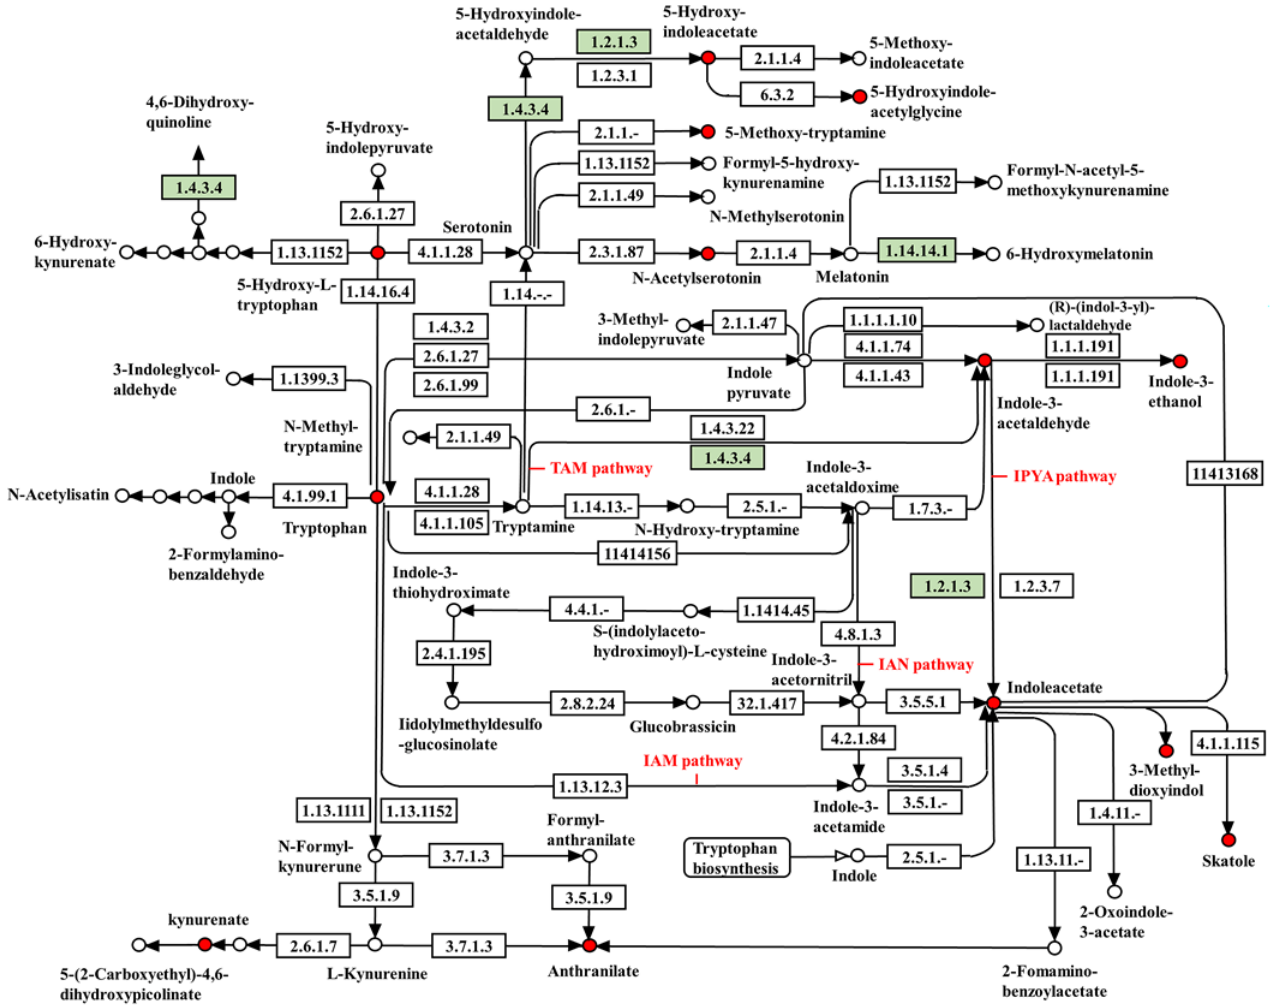
Figure 4. Diagram of the KEGG pathway of tryptophan metabolism from the J-15 genome combined with the metabolome. Red dots indicate that the material is the material tested in this LC-MS. Green markers are genes related to the IAA synthesis pathway identified in the J-15 genome. Not all target genes and metabolites are included in the